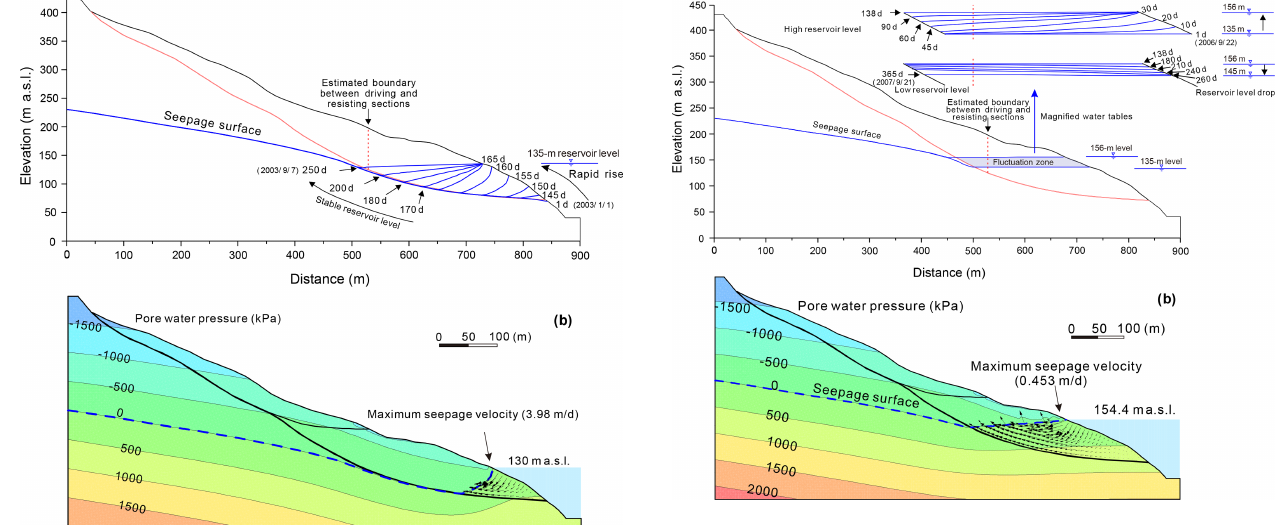
Figure 15. (a) Simulated groundwater tables as the variation in reservoir water level from 22 September 2006 to 21 Septem- ber 2007, (b) simulated pressure contours and flow vector on 11 July 2007 (day b + 260) during drawdown